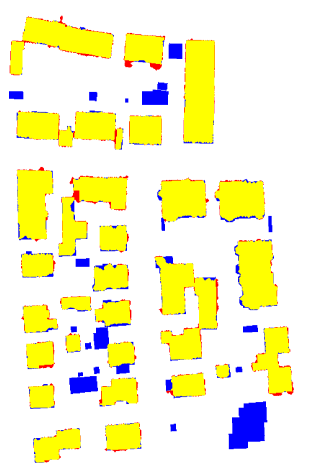
Figure 7. Buildings classification (correctly classified as yellow, misclassified as red, missing as blue) .